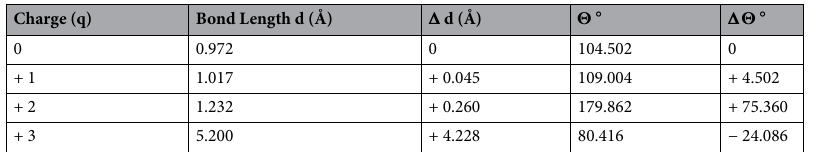
− 19 coulombs per